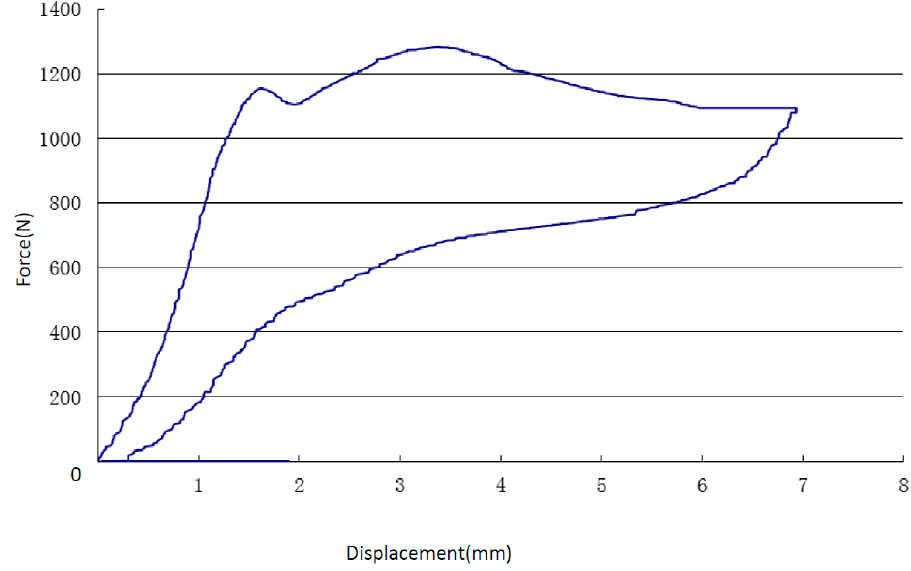
Figure 6. Force–displacement graph hydrostatic experiment.